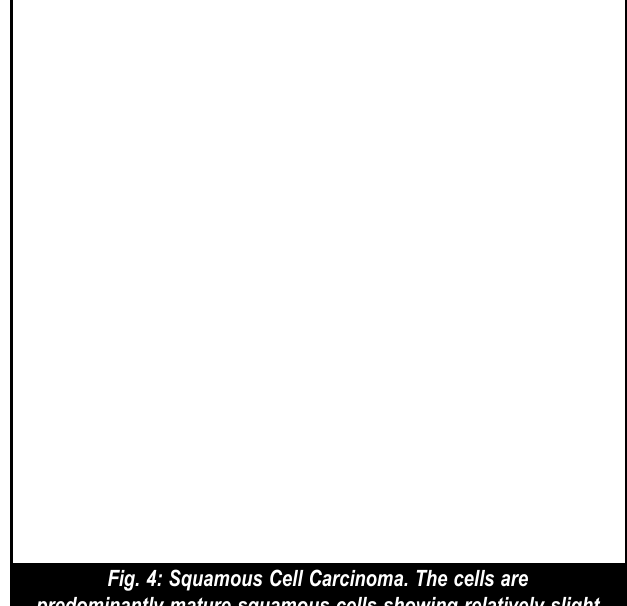
Fig. 4: Squamous Cell Carcinoma. The cells are predominantly mature squamous cells showing relatively slight atypicality. Horn peral is also seen. (H & E, x